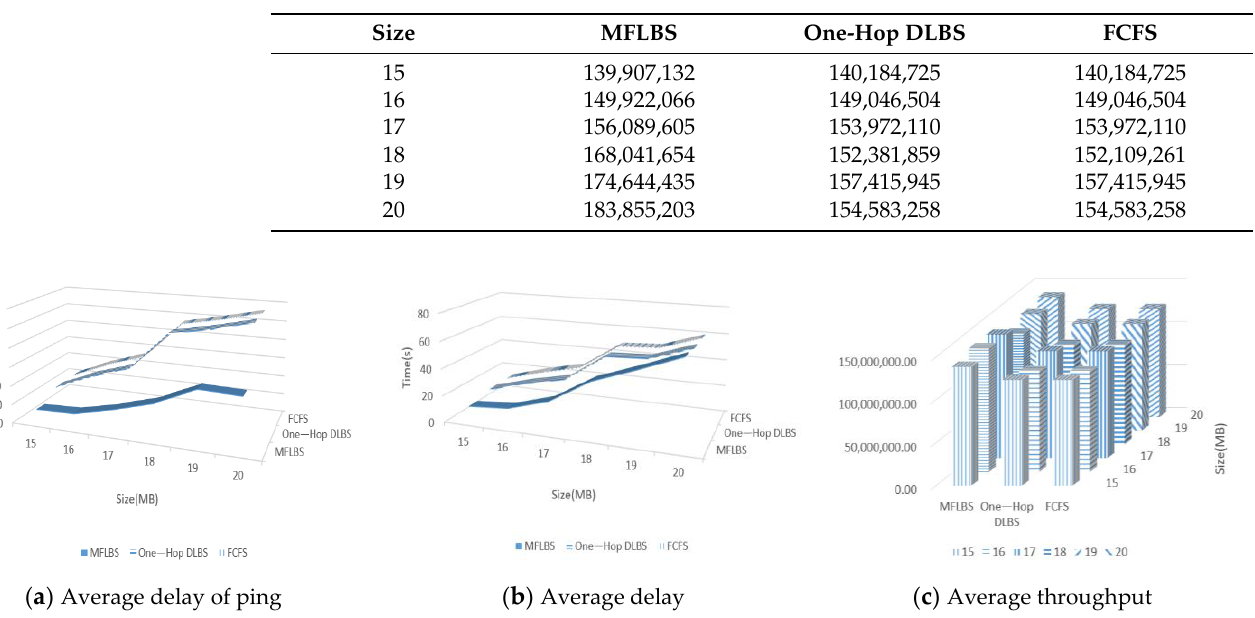
Figure 7. Three algorithms in mesh topology under uniform pattern. Table 7. Average throughput (MB) in mesh topology under uniform pattern.